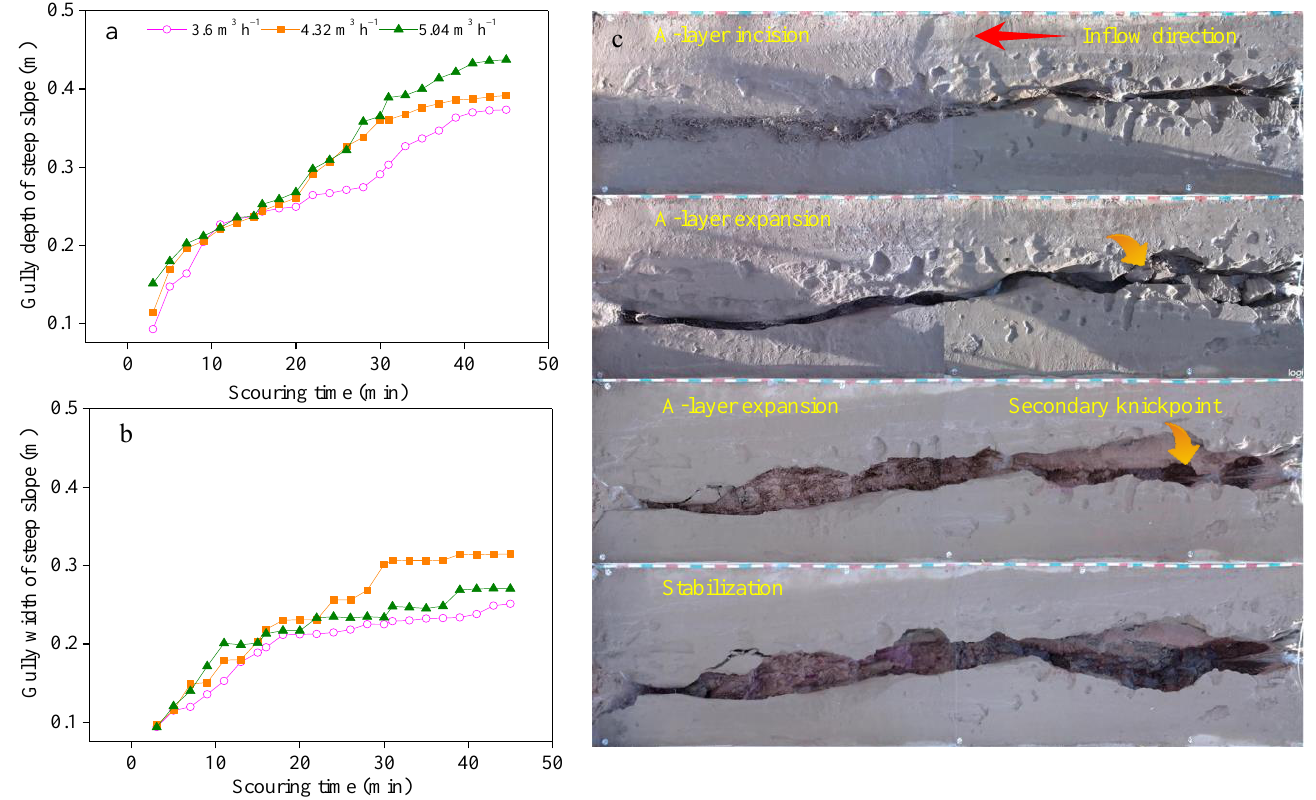
Figure 4. ( a ) Variation in gully depth; ( b ) Variation in gully width; ( c ) Images of gully morphology on the steep slope in the stages of A–layer incision, A–layer expansion, B–layer incision and stabilization, respectively.